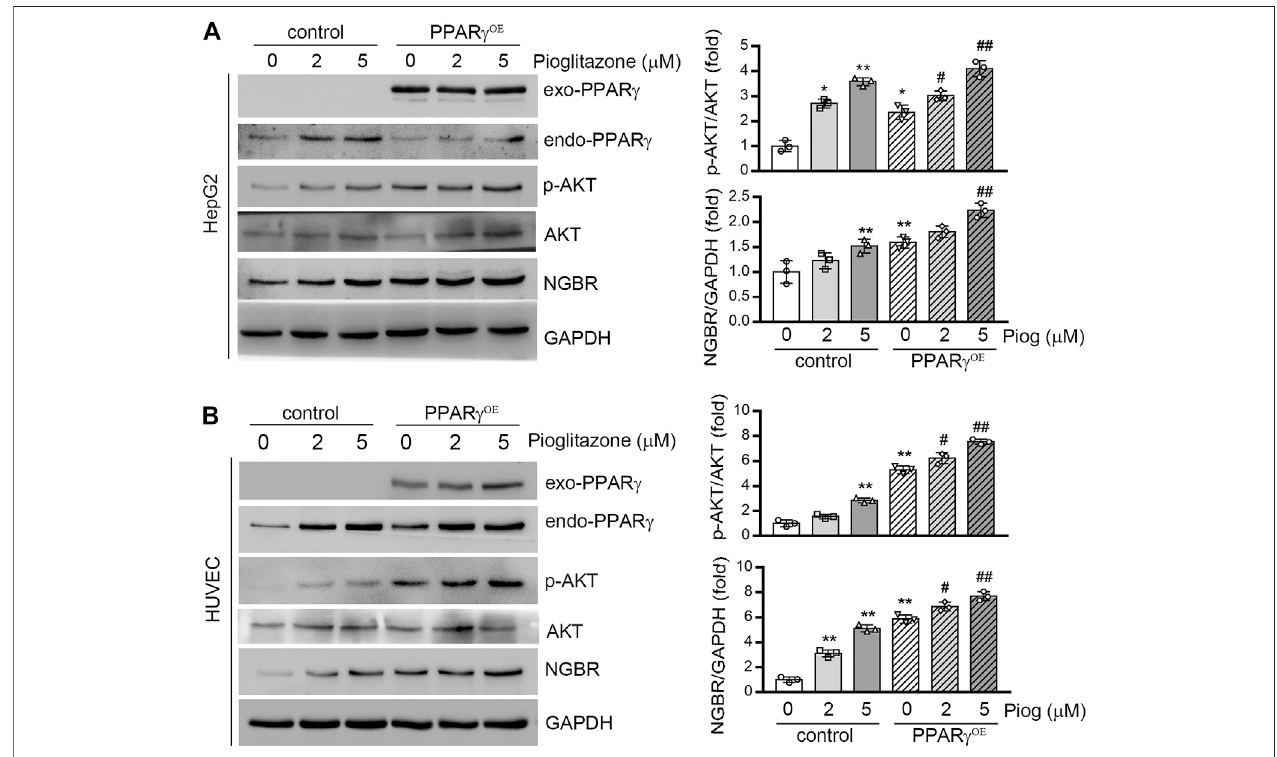
FIGURE2| OverexpressionofPPAR γ increasesNGBRexpression. HepG2cells (A) orHUVEC (B) weretransfectedwiththecontrolvector(pEGFP-C2)orPPAR γ overexpression vector (pEGFP-PPAR γ , PPAR γ OE ) for 24 h. The cells were then treated with pioglitazone at the indicated concentrations for 24 h. Expression of NGBR, endo-PPAR γ and exo-PPAR γ , p -AKT and AKT was determined by Western blot. Values were expressed as means ± SD, * p < 0.05; ** p < 0.01 vs control group ( n (cid:1) 3); # p < 0.05; ## p < 0.01 vs PPAR γ OE (lone group) ( n (cid:1)